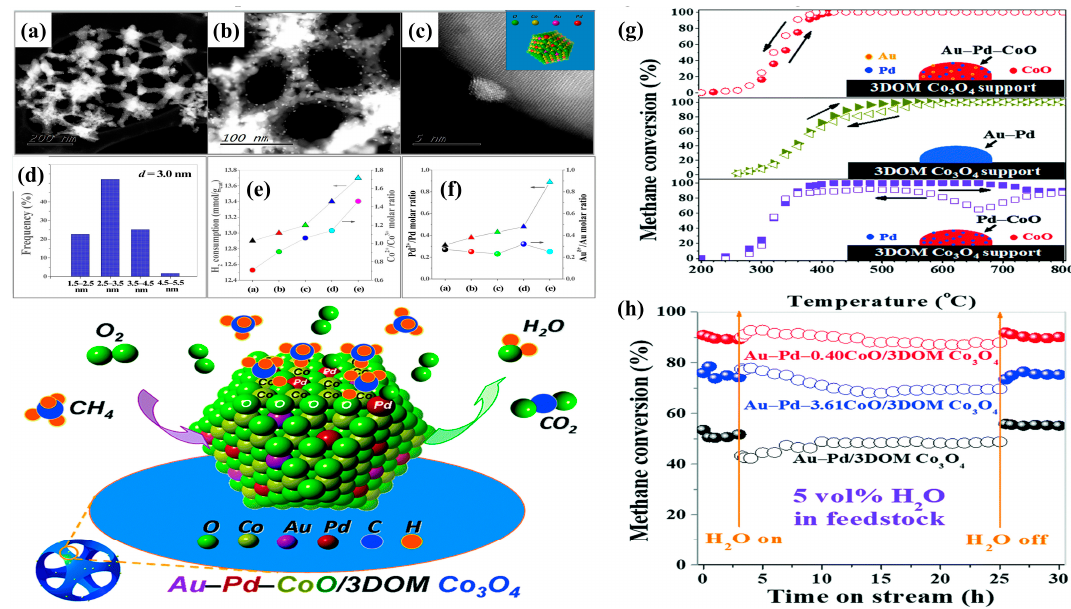
Figure 11. ( a-c ) HADDF-STEM images and ( d ) particle size distribution of Au-Pd- 3.61CoO/3DOM Co 3 O 4 ; ( e ) hydrogen consumption and Co 2+ /Co 3+ molar ratio; ( f ) Pd 2+ /Pd and Au δ + /Au molar ratios of ( a ) Au-Pd/3DOM Co 3 O 4 , ( b ) Au-Pd-0.19CoO/3DOM Co 3 O 4 , ( c ) Au-Pd-0.40CoO/3DOM Co 3 O 4 , ( d ) Au-Pd-0.90CoO/3DOM Co 3 O 4 , and ( e ) Au-Pd- 3.61CoO/3DOM Co 3 O 4 ; ( g ) methane conversion; ( h ) methane conversion as a function